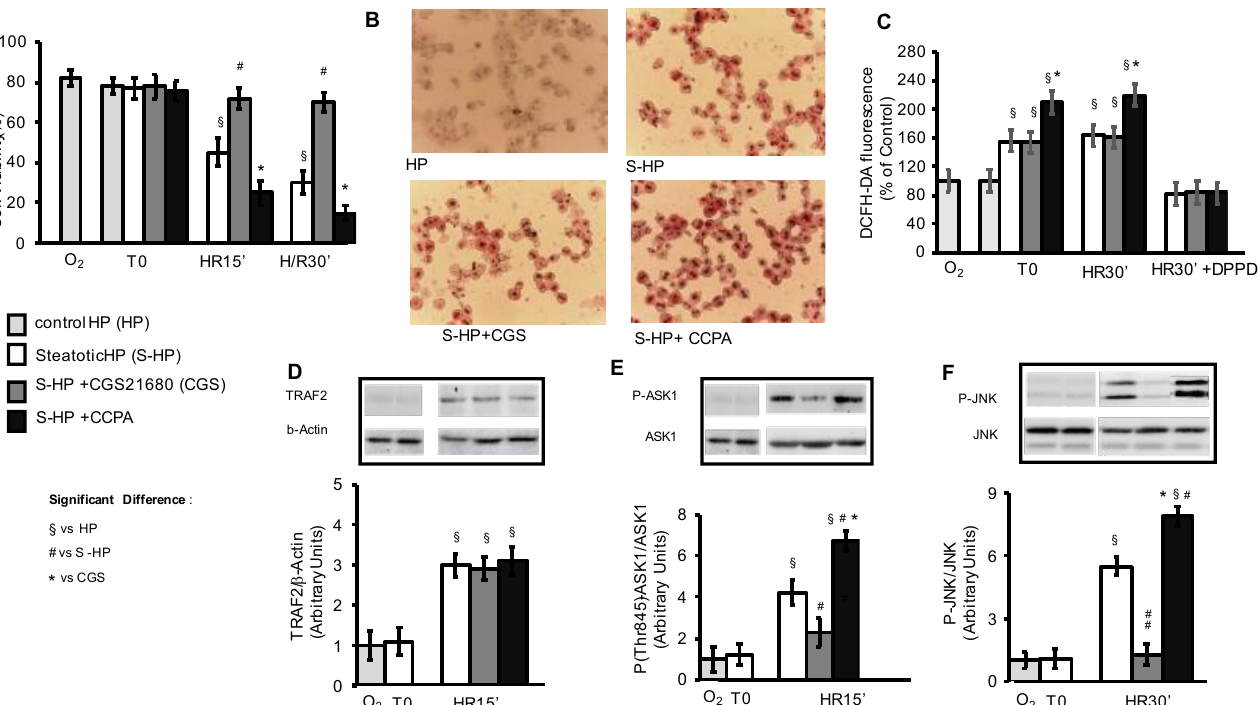
Figure 1. A2AR and A1AR pharmacological stimulation of primary steatotic mouse HP: effects on HR injury, OS production, TRAF2 levels and ASK1/JNK activation. Control (HP) or steatotic hepatocytes (S-HP) pre-exposed or not to the A2AR agonist CGS21680 (5 µM), to the A1R agonist CCPA (100 µM) or to the antioxidant DPPD (5 μ M) were stored at 4 °C in hypoxic conditions for 8 h in presence (S-HP) or absence (HP) of palmitic acid (PA, 50 μ M) and then reoxygenated at 37 °C for 30 min. ( A ) Cell viability, ( B ) Visualization of lipid intracellular content, ( C ) Oxidant species (OS) production, ( D ) TRAF2 expression, ( E ) ASK1 activation, ( F ) JNK activation. The different parameters were estimated after normoxic incubation (O2), and/or at the end of hypoxic storage (To) and after 15 and/or 30 min of reoxygenation (HR). The results are expressed as mean of 3–5 experiments ± SD. Statistical significance: * § # p < 0.05, ## p <